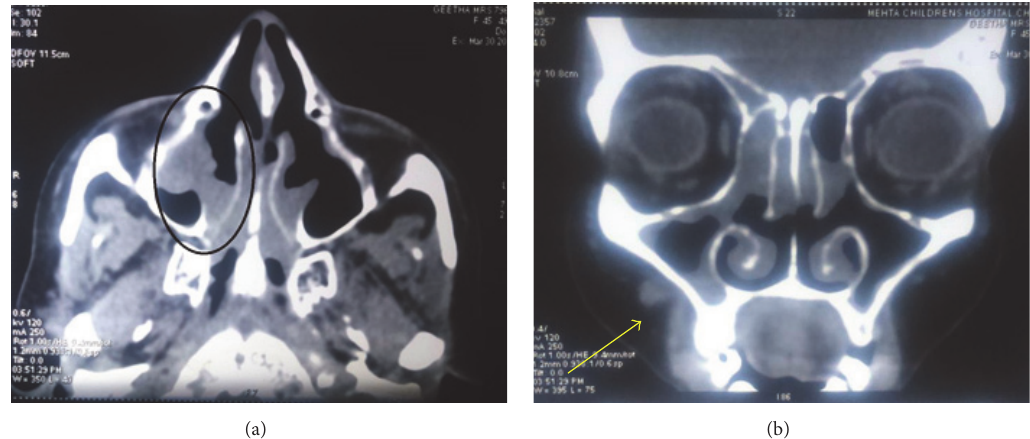
Figure 5: (a) CT image of the lesion: right posterior maxillary region showing irregular soft tissue growth. (b) Coronal CT view in which the location of the haemangioma is being shown by an arrow.